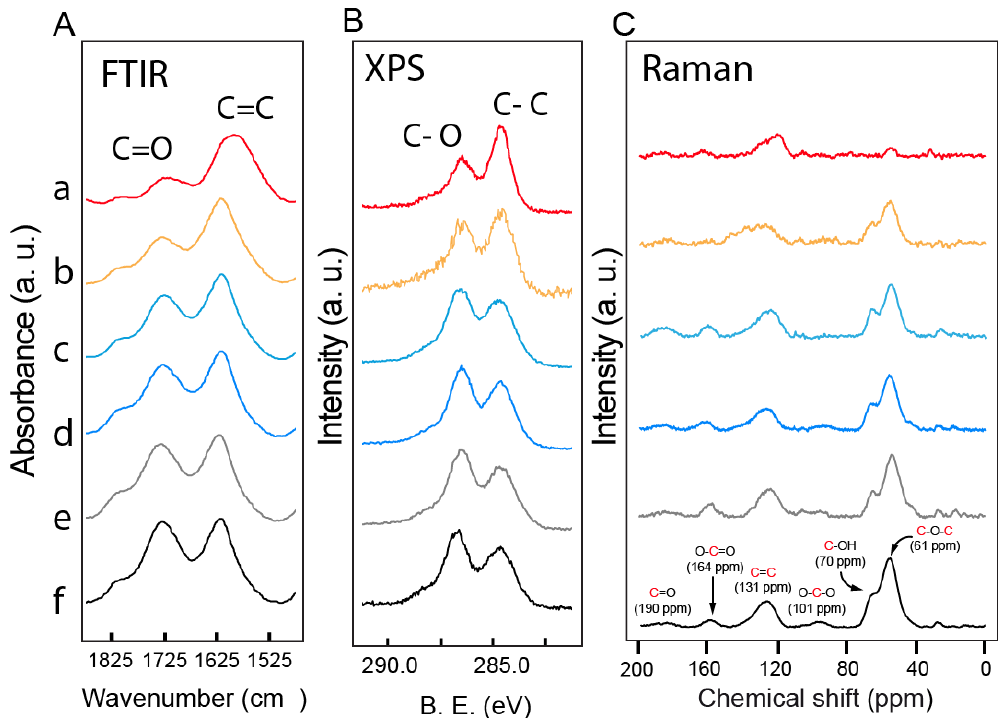
Figure 2. ( A ) FTIR; ( B ) XPS C1s; and ( C ) Raman spectrum of: ( a ) GO-Sn; ( b ) GO-Fe; ( c ) GO-Zn; ( d ) GO-Al; ( e ) GO-Mg; and ( f ) GO materials. 13 C direct pulse solid-state NMR (MAS) spectrum of GO-Sn, GO-Fe, GO-Zn, GO-Al, GO-Mg and GO materials (speed of rotation: 12.5 kHz).